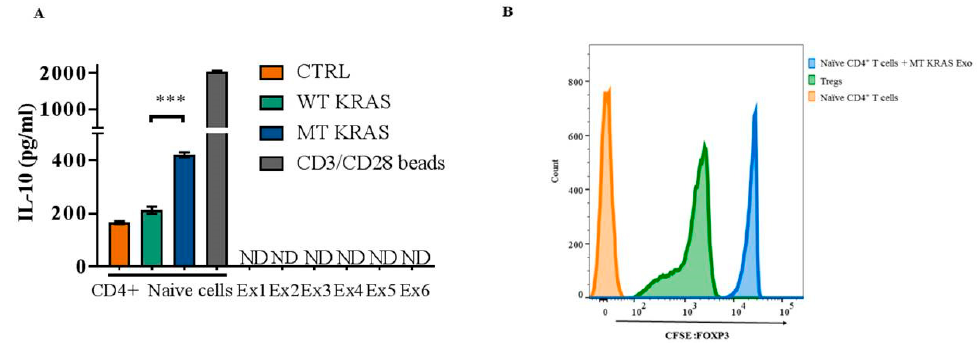
Figure 4. MT KRAS-mediated phenotypic switching of T cell to Treg-like cells is independent of IL-10, and the converted Treg-like cells can suppress naïve CD4 T cell proliferation. ( A ) MT KRAS (Ex1–4) and WT KRAS (Ex5–6) TDEs isolated from the serum of NSCLC patients or naïve CD4 + CD25 − T cells incubated with WT or MT KRAS TDEs for 24 h were evaluated for release of IL-10 via enzyme-linked immunosorbent assays (ELISA). CD3 / CD28 beads were used as a positive control. Graph shows the mean and standard deviation of quadruple wells. ND, not detectable. *** p < 0.001 (two-tailed unpaired t-test). ( B ) Carboxyfluorescein succinimidyl ester (CFSE)-labeled naïve CD4 + CD25- T cells isolated from healthy donor PBMCs were incubated with MT KRAS or WT KRAS TDEs for 24 h, and cell proliferation was assessed by flow cytometry. The plot shows the cell count calculated as the fluorescence intensity based on gating cells positive for CFSE dye. As a positive control, CFSE-labeled naïve CD4 + CD25 − T cells were incubated with CD4 + CD25 hi CD127 low Tregs isolated from the same donor.